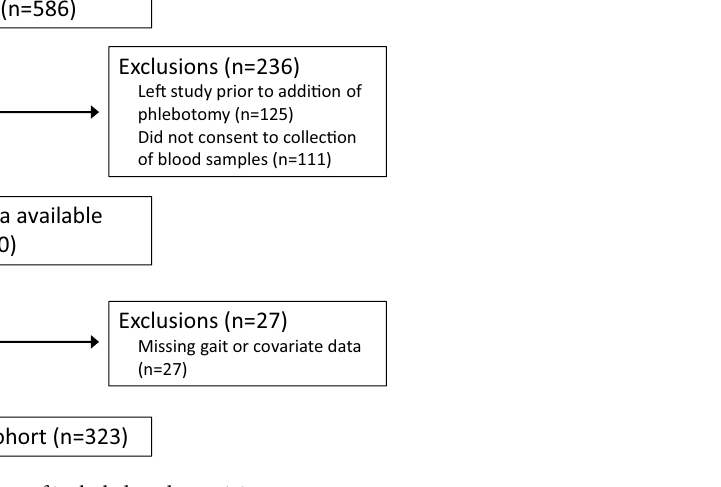
Figure 1. Flow diagram of included study